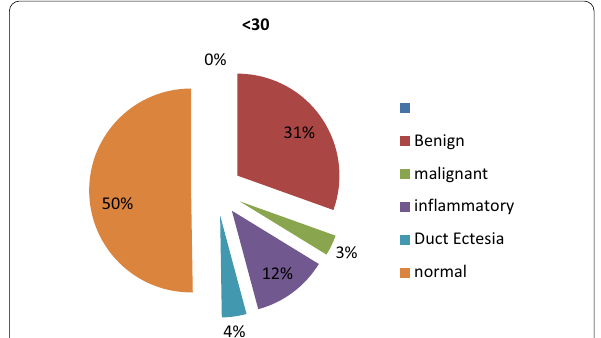
Fig. 1 Percentages of different breast lesions in patients